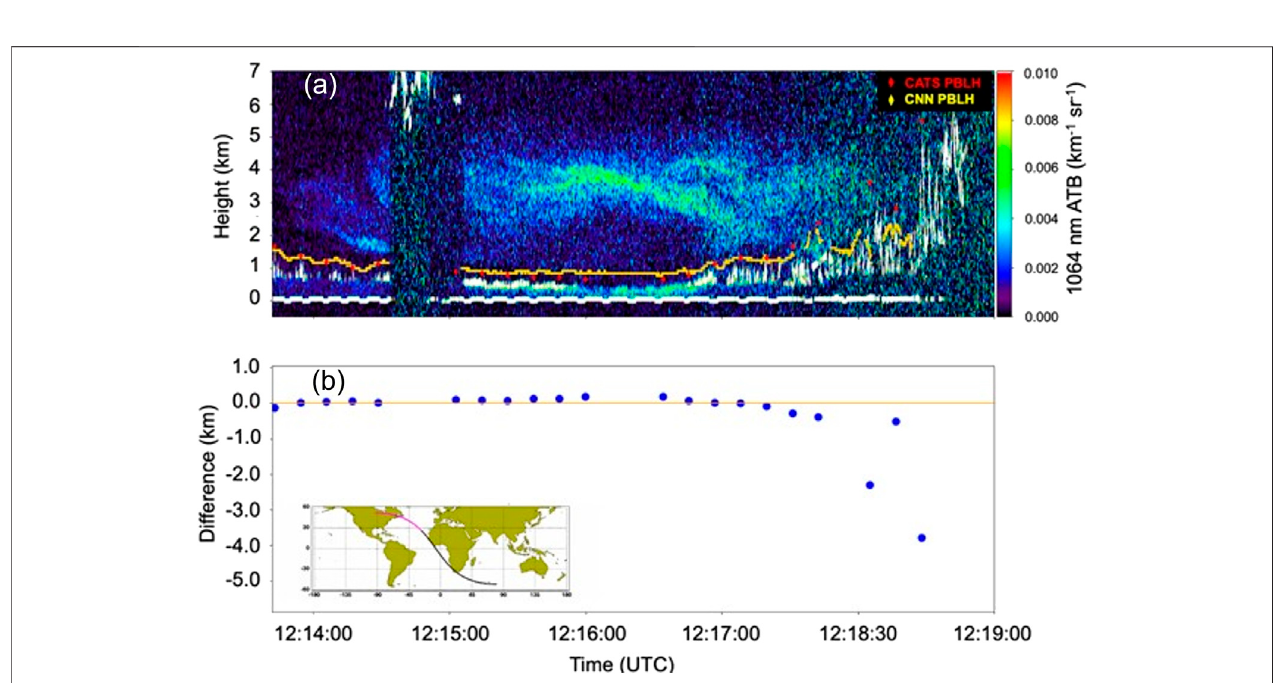
FIGURE 2 | (A) CATS 1064 nm attenuated total backscatter along the track shown in the map inset for September 15, 2015 at 12:14-12:19 UTC with the PBL height overlaid from the threshold (red dots) and CNN (yellow dots) techniques. (B) The difference (CNN-threshold) for the two techniques for the same scene.